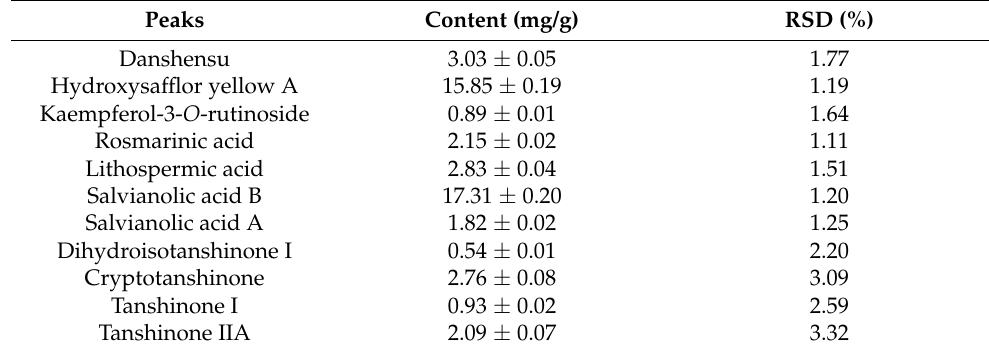
Table 4. Content of 11 compounds in the multi-component combination (MCC). Peaks Content (mg/g) RSD (%) Danshensu Hydroxysafflor yellow